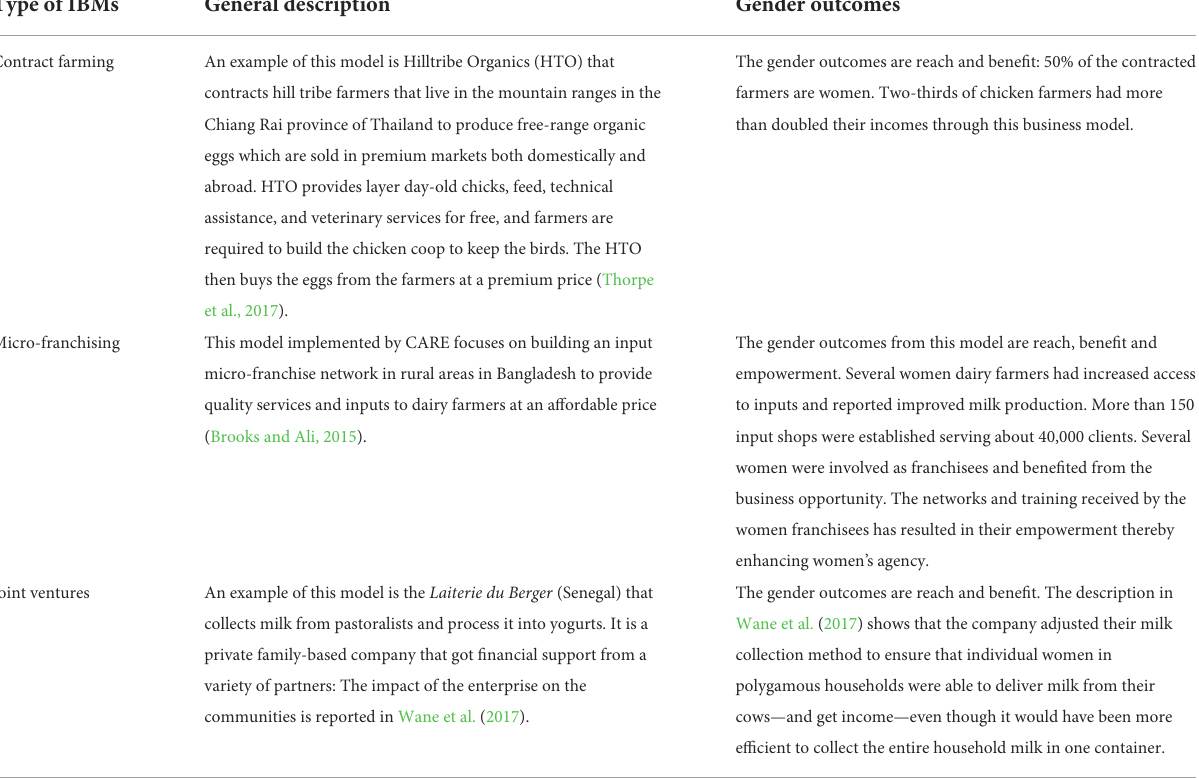
TABLE 1A Examples of buyer-driven gender-inclusive business models, and reported gender